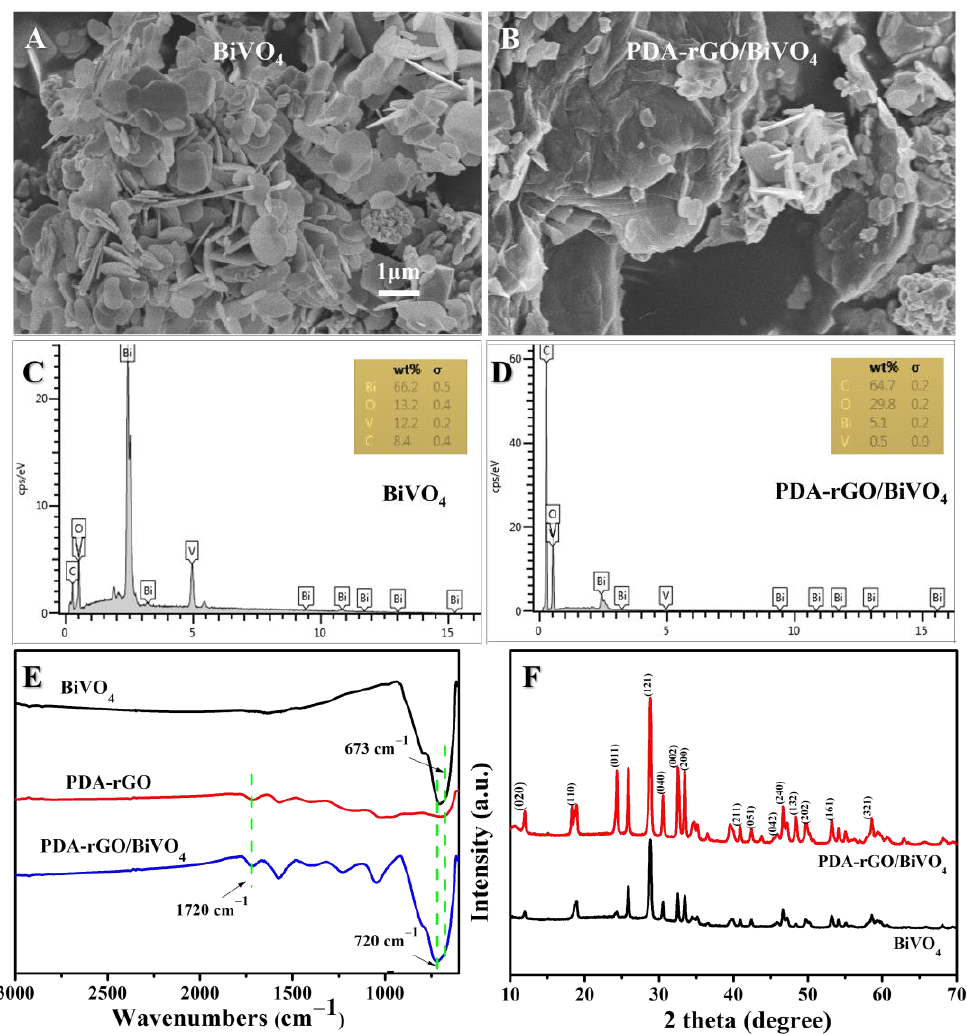
Figure 1. SEM images of ( A ) BiVO 4 , ( B ) PDA-rGO/BiVO 4 ; EDX analysis of ( C ) BiVO 4 , ( D ) PDA- rGO/BiVO 4 ; ( E ) FT-IR spectra of BiVO 4 , PDA-rGO and PDA-rGO/BiVO 4 ; and ( F ) XRD patterns of BiVO 4 and PDA-rGO/BiVO 4 .